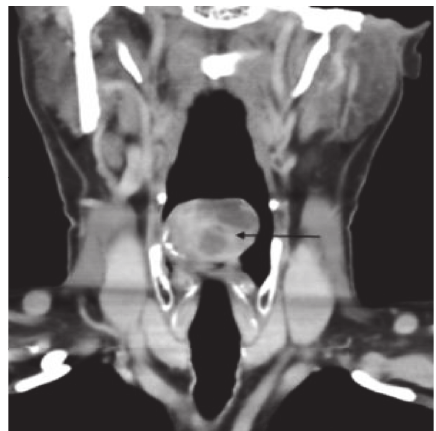
Figure 3: Coronal postcontrast image showing the mass lesion with nonenhancing